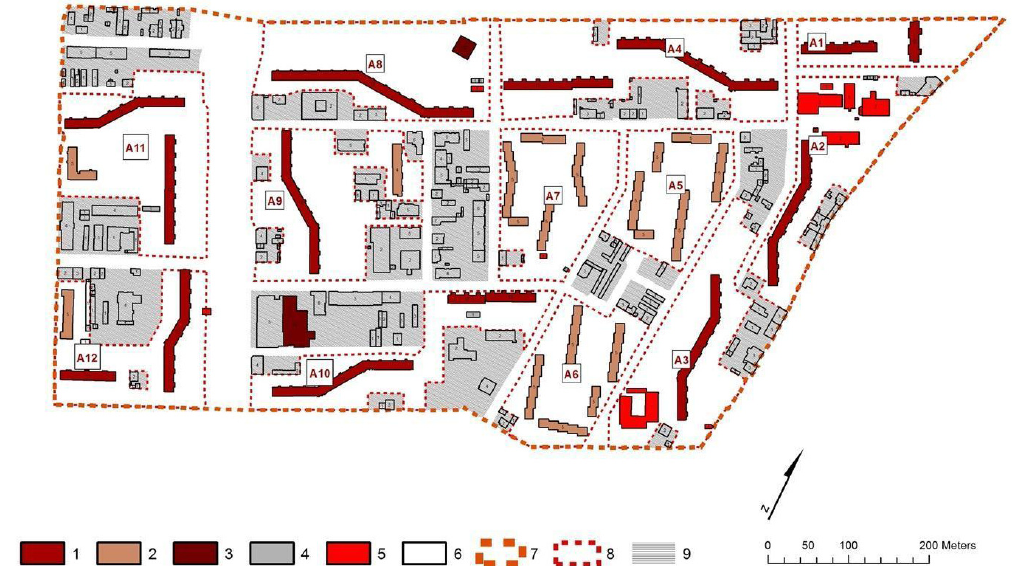
Figure 1. Typology of built structures of the Zgierska‐Stefana estate, Bałuty, Lodz. Notes: (1) Twelve‐floor wave blocks; (2) four‐ or‐five‐floor blocks of flats; (3) tower buildings; (4) auxiliary structures; (5) services, (6) buildings in the historical parts; (7) site limits; (8) historical development; A1–A12 are unit IDs.